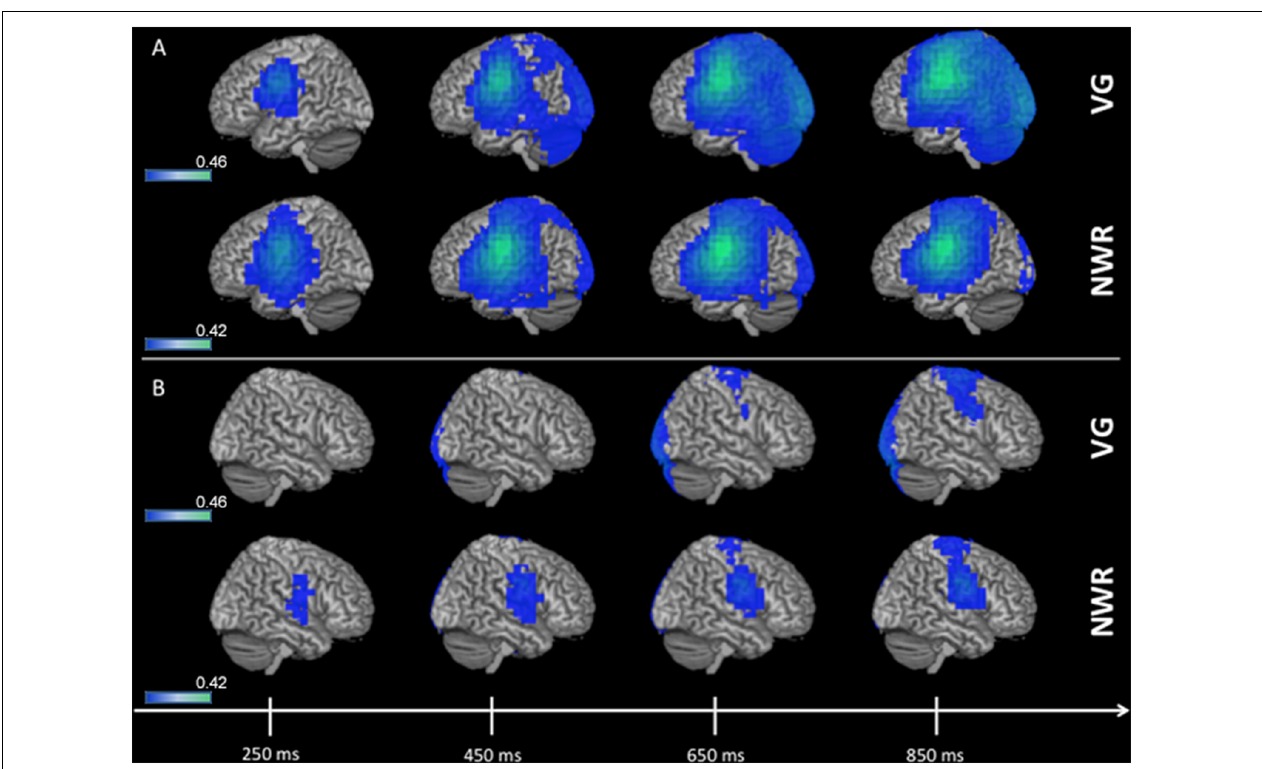
FIGURE 2 | 3D overlay of average changes (reduction of beta power, in blue) during stimulus encoding (stimulus-locked) for both the verb generation (VG) and non-word repetition (NWR) tasks in the strong left group. Following auditory presentation of the stimulus, reduced beta power is observable over temporal and parietal regions in the left hemisphere (A) and, to a lesser extent, over right frontal regions (B) . Individual beta power changes were spatially normalized to MNI space and averaged within each group for each condition. The group-averaged beta power changes were then thresholded at 25% of the absolute maximum F -value over the shown time course and displayed on 3D rendered brains in MNI space. Color bars are in pseudo-F values (in dB). Deep sources are not projected to the surface in this